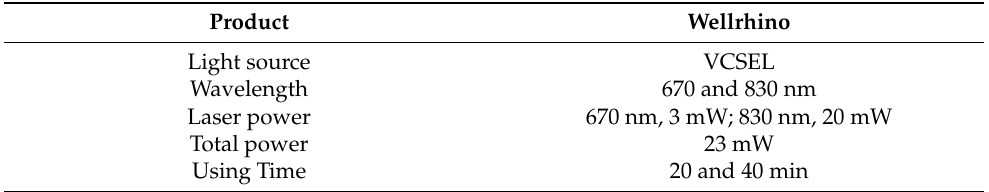
Table 2. Parameters of the irradiation